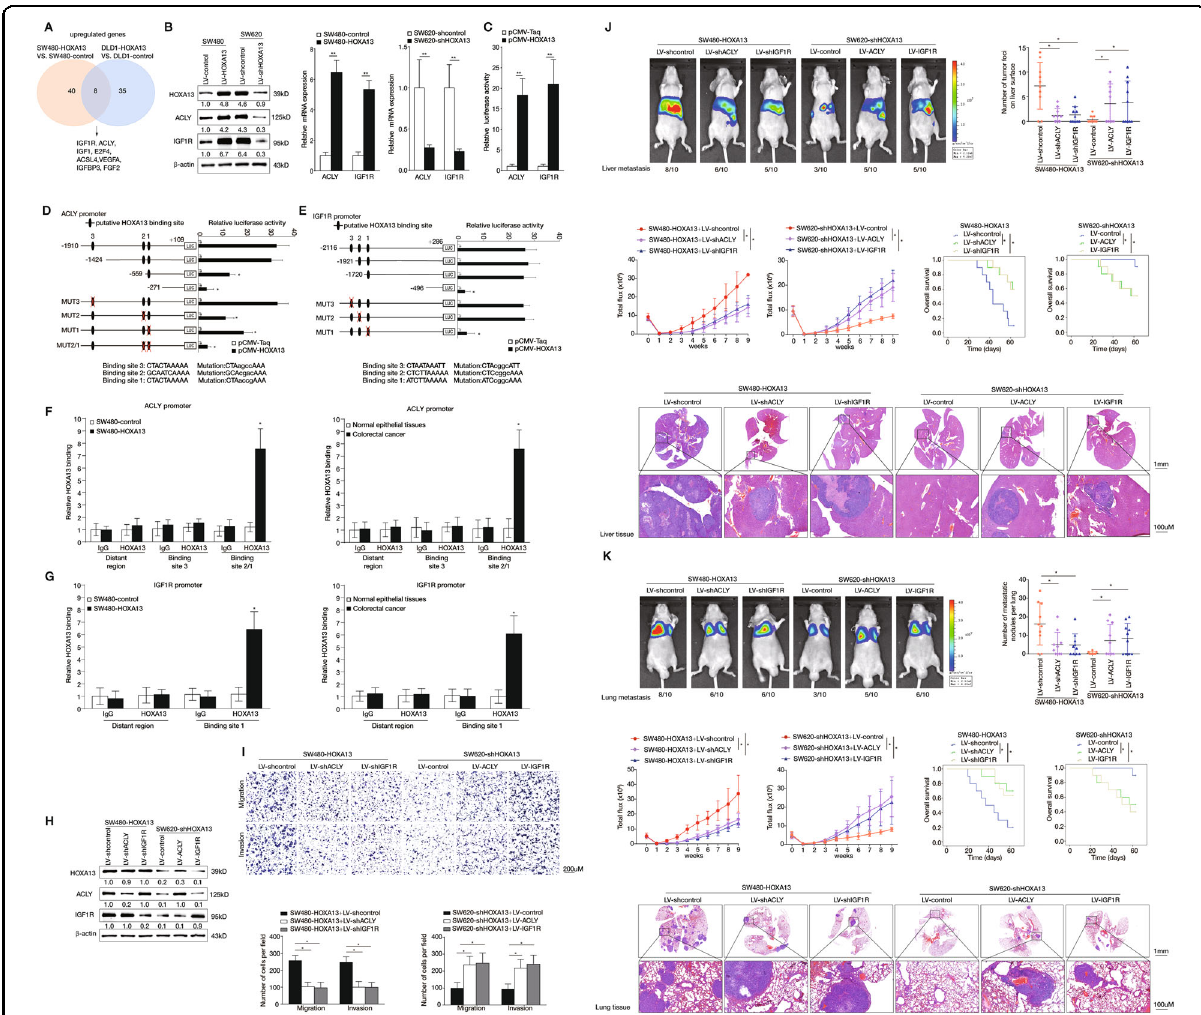
Fig. 2 HOXA13 promotes CRC metastasis via upregulating ACLY and IGF1R. A Venn diagram presenting the overlap of upregulated genes in both SW480-HOXA13 and DLD-1-HOXA13 cell lines (fold change >2.0). B (Left) Western blotting analysis of ACLY and IGF1R expression in the corresponding CRC cell lines after lentivirus transfection. (Right) Real-time PCR analysis of ACLY and IGF1R expression in the corresponding CRC cell lines after lentivirus transfection. C Luciferase reporter assay displayed the promoter activities of ACLY and IGF1R after SW480 cells were co-transfected with pCMV-HOXA13 and ACLY or IGF1R promoter constructs. D , E HOXA13-responsive regions in the ACLY and IGF1R promoter were analyzed by deletion and selective mutation. Serially truncated and mutated ACLY or IGF1R promoter constructs were co-transfected with pCMV-HOXA13, and relative luciferase activities were determined. Left-component was the schematic constructs, and right-component presented the relative luciferase activities. F , G ChIP assays revealed the direct binding of HOXA13 to the ACLY ( F ) or IGF1R ( G ) promoter in SW480-HOXA13 cells and the enriched binding sites of endogenous HOXA13 to the ACLY or IGF1R promoter in CRC tissues. The amounts of immunoprecipitated products were examined by real-time PCR. H Western blotting analysis presenting ACLY and IGF1R expression in SW480 and SW620 cells after lentivirus transfection. I Transwell assays showed that downregulation of ACLY and IGF1R reduced the migration and invasion abilities of SW480-HOXA13 cells, while upregulation of ACLY and IGF1R increased the migration and invasion abilities of SW620-shHOXA13 cells. J In vivo liver metastatic assays. Four stable cell lines were injected into the spleens of nude mice ( n = 10 mice per group). Representative bioluminescent imaging, incidence of liver metastasis, intensity of bioluminescence signals, overall survival times, liver tissues ’ HE staining in each group, and the number of metastatic liver nodules were shown. The scale bars represent 1 mm (low magni fi cation) and 100 μ m (high magni fi cation). K In vivo lung metastatic assays. Four stable cell lines were injected into the tail veins of nude mice ( n = 10 mice per group). Representative bioluminescent imaging, incidence of lung metastasis, intensity of bioluminescence signals, overall survival times, lung tissues ’ HE staining in each group and the number of metastatic lung nodules were shown. The scale bars represent 1 mm (low magni fi cation) and 100 μ m (high magni fi cation). * P < 0.05, ** P < 0.01. Data are displayed as the mean ±